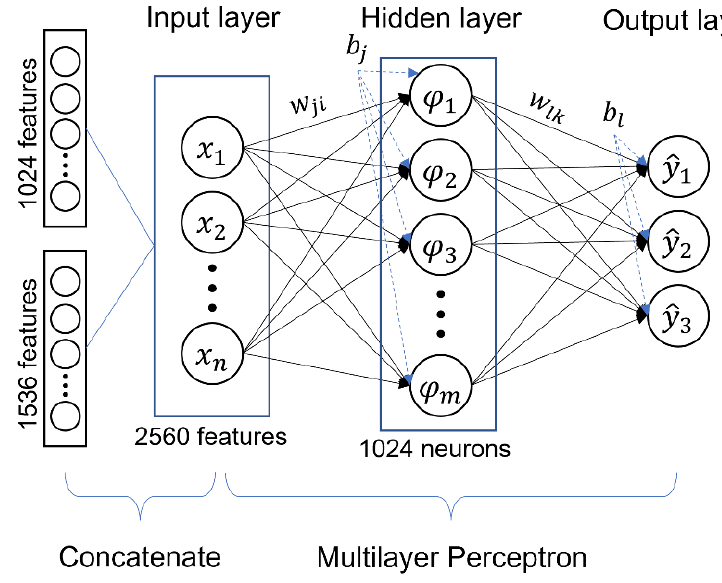
Figure 10. Architecture of our classifier.